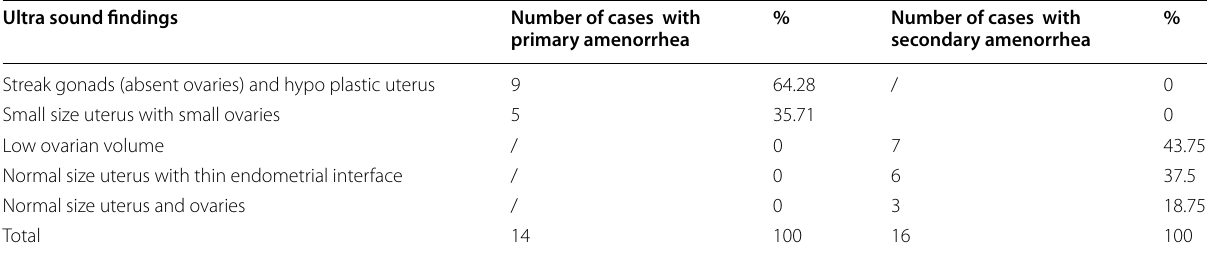
Table 2 The ultra sound finding detected in patients with primary amenorrhea and in patients with secondary amenorrhea Ultra sound findings